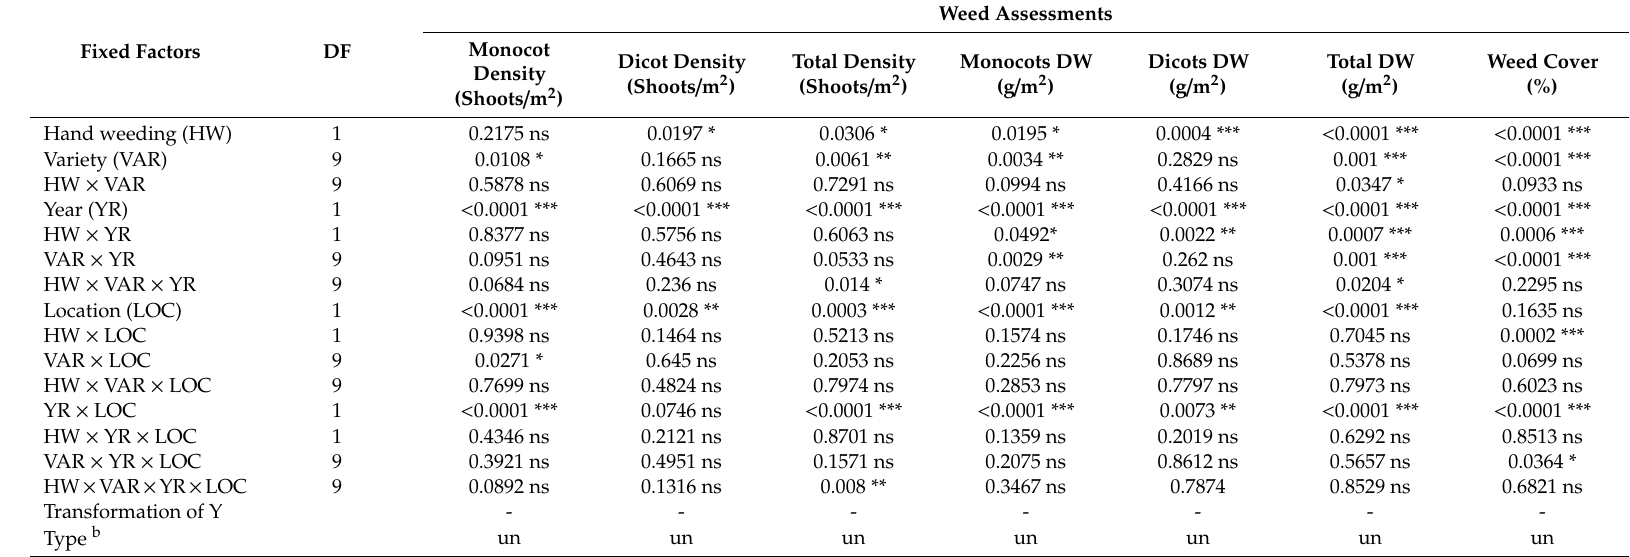
Table 6. ANOVA table with P-values for the e ff ects of the main factors of hand weeding, te ff variety, location, and year and their interactions on weed assessments.